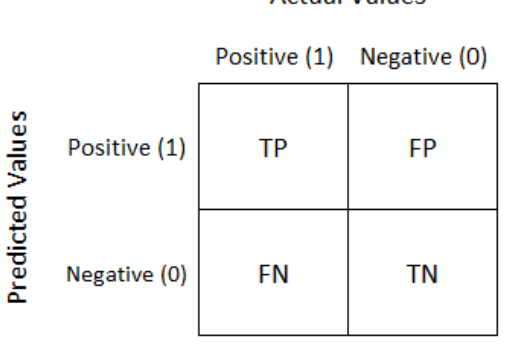
Figure 9. Confusion matrix [36]. The symbols TP , TN , FP , and FN indicate true positive, true negative, false positive, and false negative, respectively